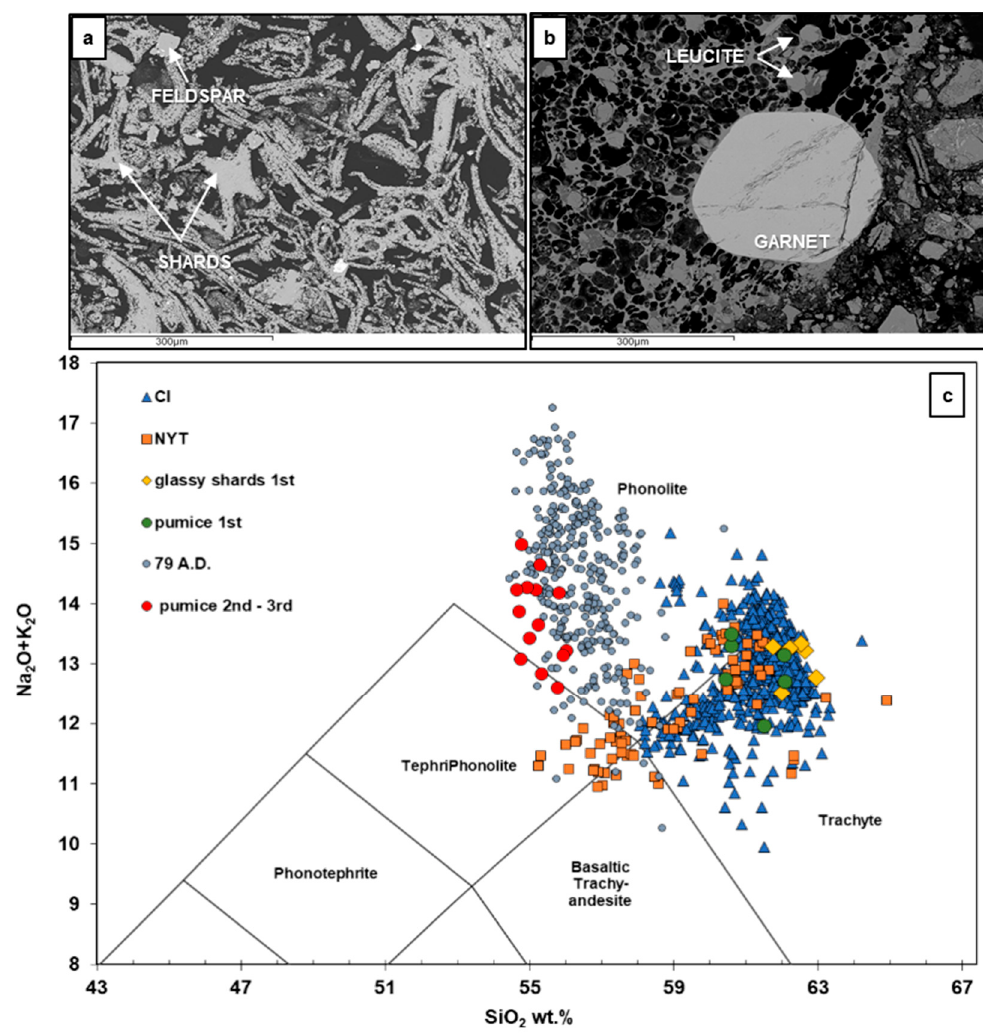
Figure 8. ( a ) Backscattered SEM image of glassy shards partially coated by a thin layer of micrometric sanidine in VP2 sample; ( b ) backscattered SEM image of leucite bearing pumice with garnet in VP14 sample; ( c ) classification of glassy shards and pumice fragments in Villa del Pezzolo mortars compared with Campi Flegrei and 79 A.D. Somma-Vesuvius volcanic glasses (CI; NYT; 79 A.D.; [38], using a TAS diagram [36]). Abbreviations: CI: Campanian Ignimbrite; NYT: Neapolitan Yellow Tuff; 79 A.D: 79 A.D. Somma-Vesuvius eruption; VP: Villa del Pezzolo pumice.